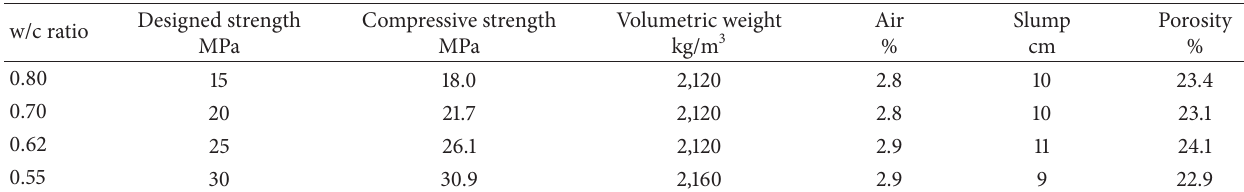
Table 3: Concrete properties.